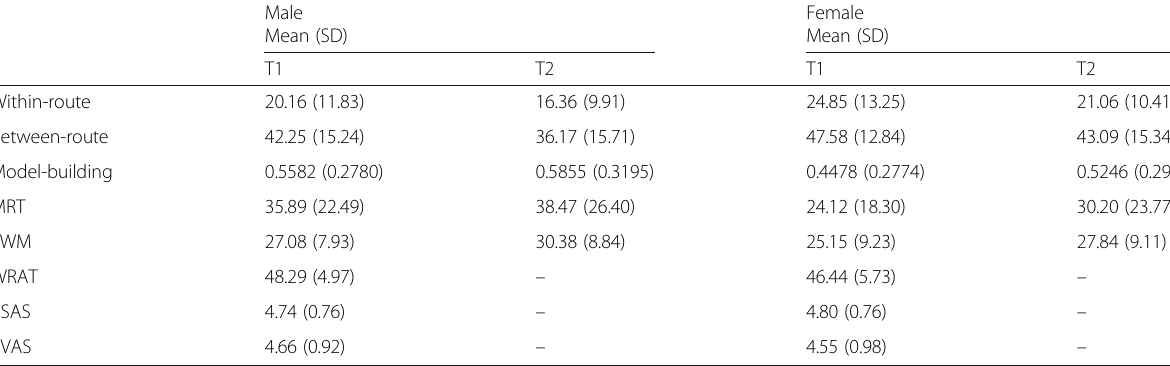
Table 2 Descriptive statistics by participant sex for T1 and